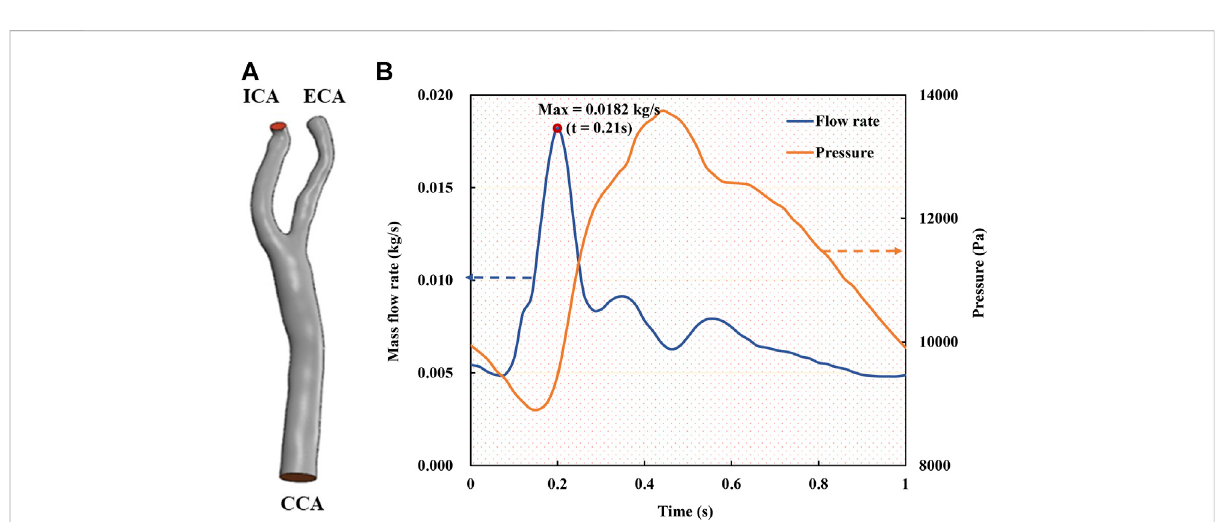
FIGURE 1 Geometricmodelandboundaryconditionsofthecarotidbifurcatedartery. (A) .GeometricmodelofcarotidbifurcatearterywithbranchesCCA, ICA and ECA; (B) . Unsteady boundary conditions comprising a mass fl ow rate pro fi le at CCA inlet and a pressure waveform at ICA and ECA outlets (Gharahi et al., 2016; Lopes et al.,